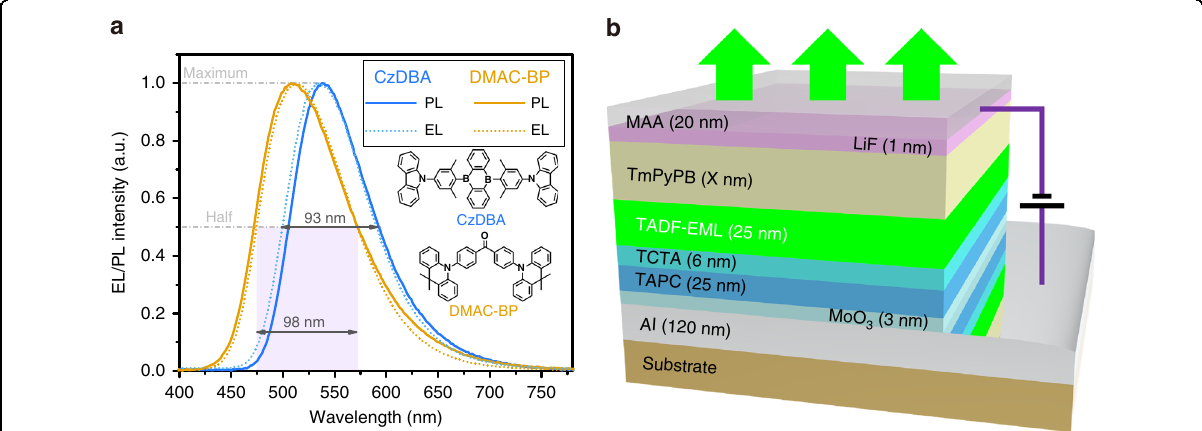
Fig. 1 Broad emission of TADF emitters and a top-emitting structure with weak light-matter coupling. a Molecular structure and PL spectra (solid lines) of the CzDBA and DMAC-BP TADF emitters, and EL spectra (dotted lines) of their corresponding conventional bottom-emitting devices BE-Cz and BE-DM. b Device structure of the proposed top-emitting TADF